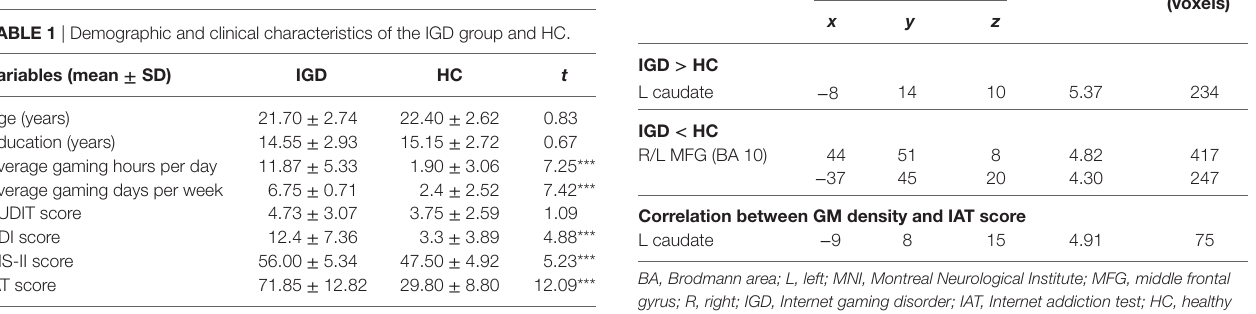
TaBle 2 | Regional gray matter (GM) differences between the IGD group and HC reveal a positive correlation with IGD severity. Brain region